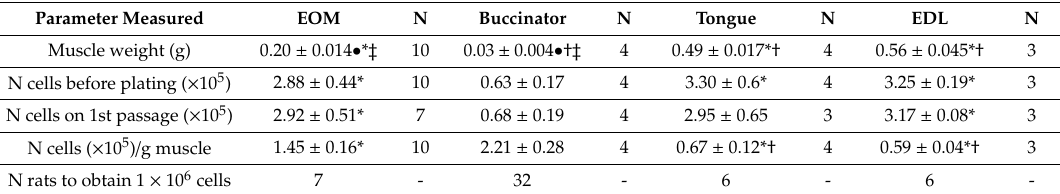
Table 1. Comparison of di ff erent parameters measured on each type of muscle from which cells were isolated. Parameter Measured EOM